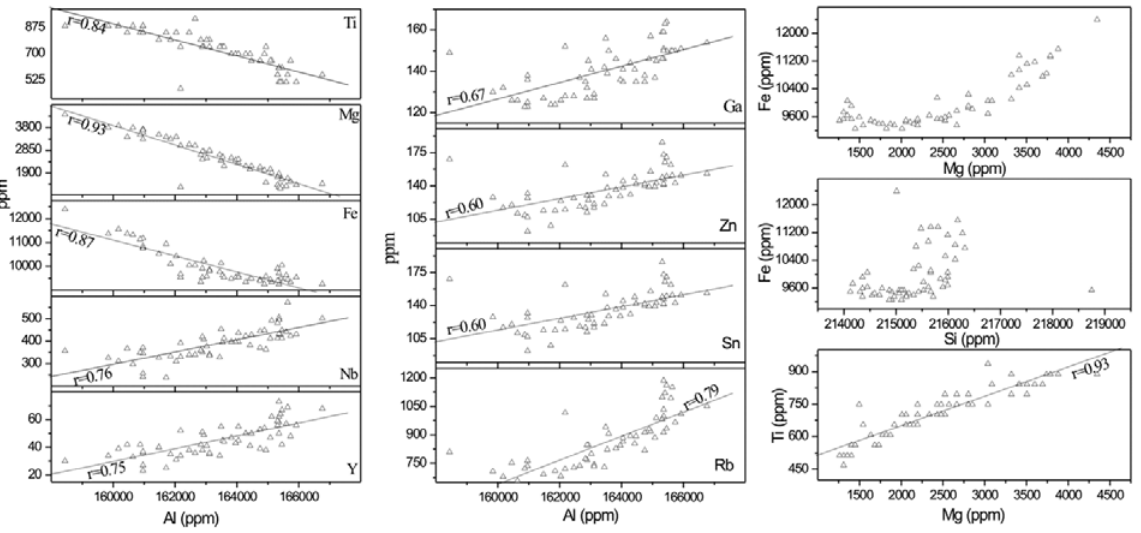
Fig. 4 – Selected bivariant diagrams showing the trend compositional of the muscovite megacrystal studied. Solid line is the best linear fit to the experimental data